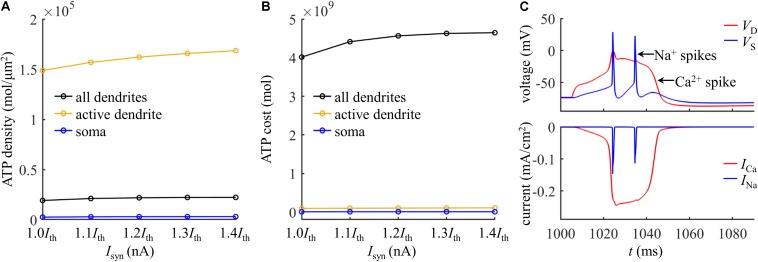
(A) ATP cost per unit membrane area during a Ca2+ spike. (B) Total ATP cost during a Ca2+ spike. The synaptic input was injected in the active dendrite, which was Isyn = 1.0Ith, 1.1Ith, 1.2Ith, 1.3Ith, and 1.4Ith. The ATP cost was, respectively, computed in the soma, active dendrite, and whole dendrites. (C) Top panel: time courses of somatic voltage VS and dendritic voltage VD. Bottom panel: time courses of underlying INa and ICa (Isyn = Ith and IS = 0 nA). VD and ICa were recorded in the active dendrite, and VS and INa were recorded in the soma.